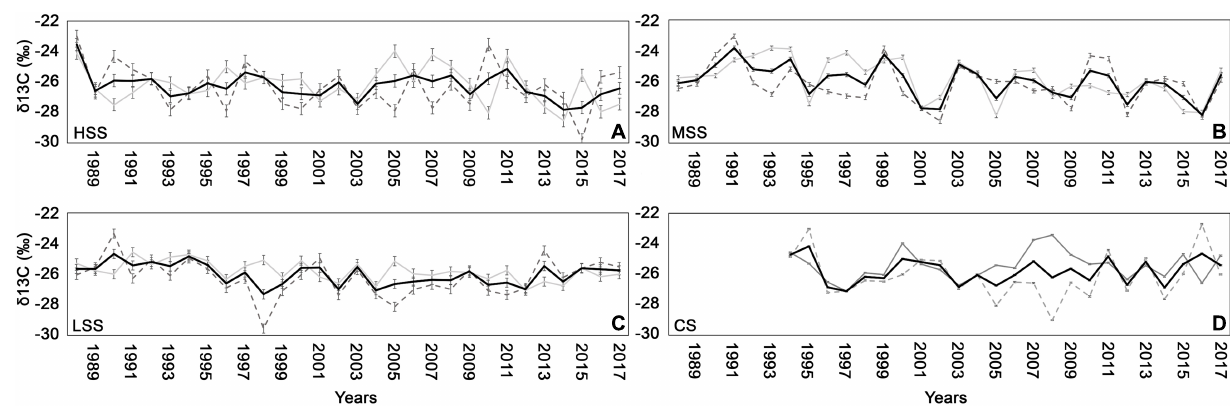
FIGURE 5 | δ 13 C chronologies ( ± standard deviation) for early-wood (gray line), late-wood (dashed gray line), and for the whole wood (black line) for (A) high severity site (HSS), (B) medium severity site (MSS), (C) low severity site (LSS), and (D) control site (CS).